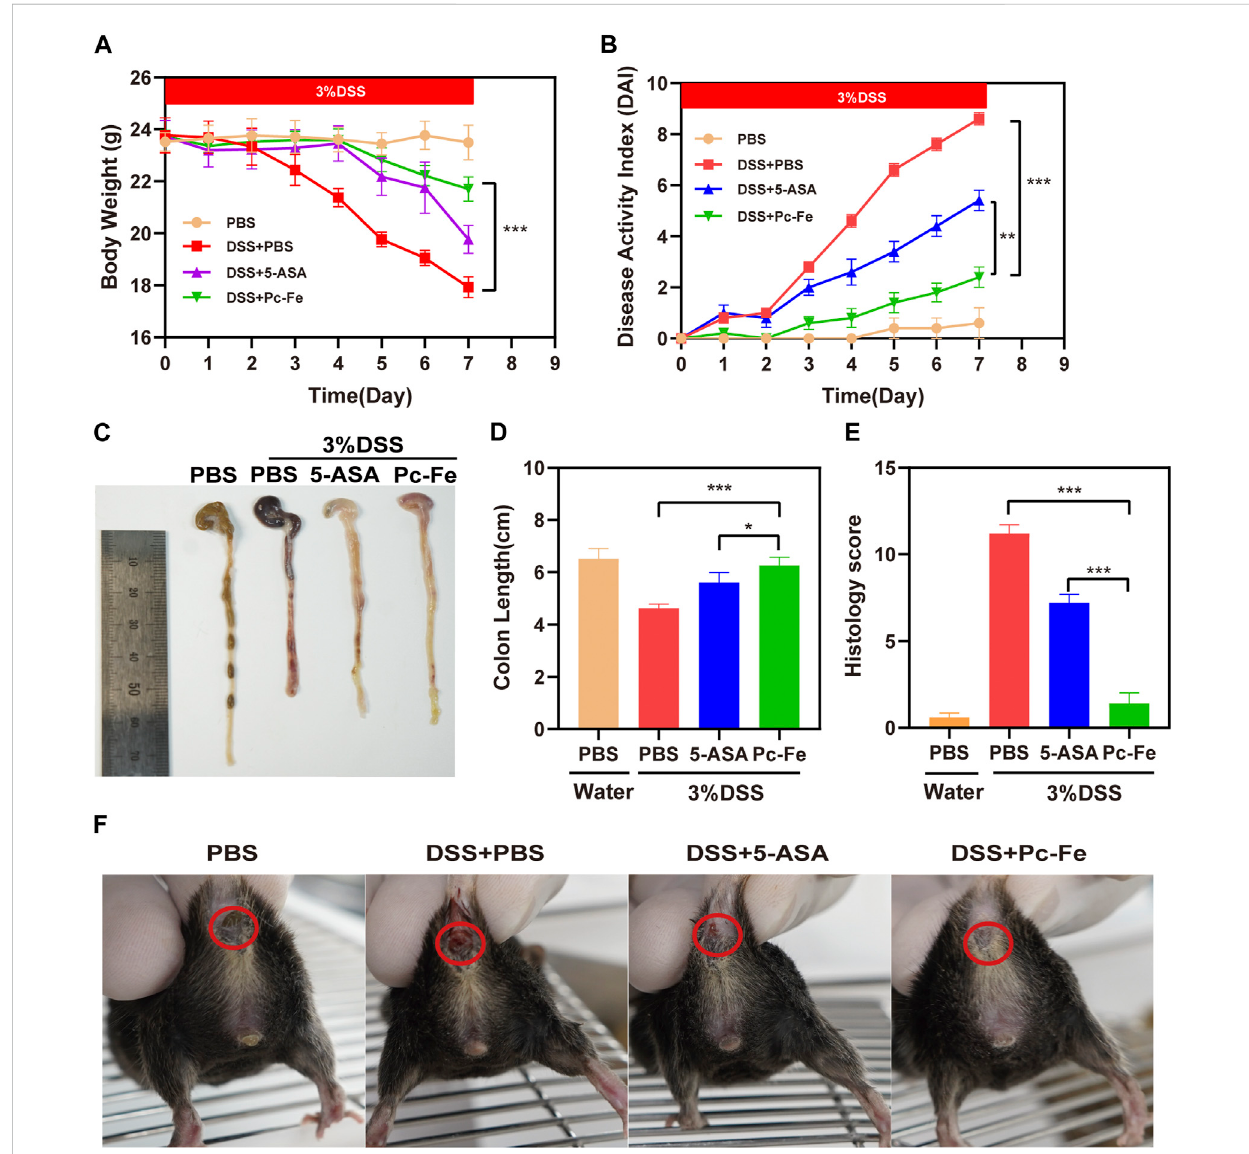
FIGURE 5 Pc-Fe alleviates UC in the DSS-induced colitis model. (A) Body weight of mice in each group for 7 days. (B) The DAI score in each group. (C) RepresentativeimagesofthecoloninthePBSgroup,theDSS+PBSgroup,theDSS+5-ASAgroupandtheDSS+Pc-Fegroupon7thday. (D) Colonlength shown as a chart. (E) The HDI scores in each group based on in fl ammatory cell in fi ltration and mucosal damage under microscopic observation. TMB is